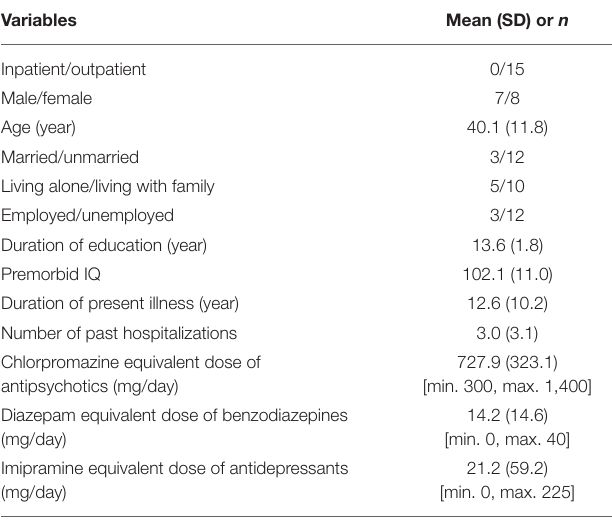
TABLE 4 | Clinical characteristics of patients ( n =